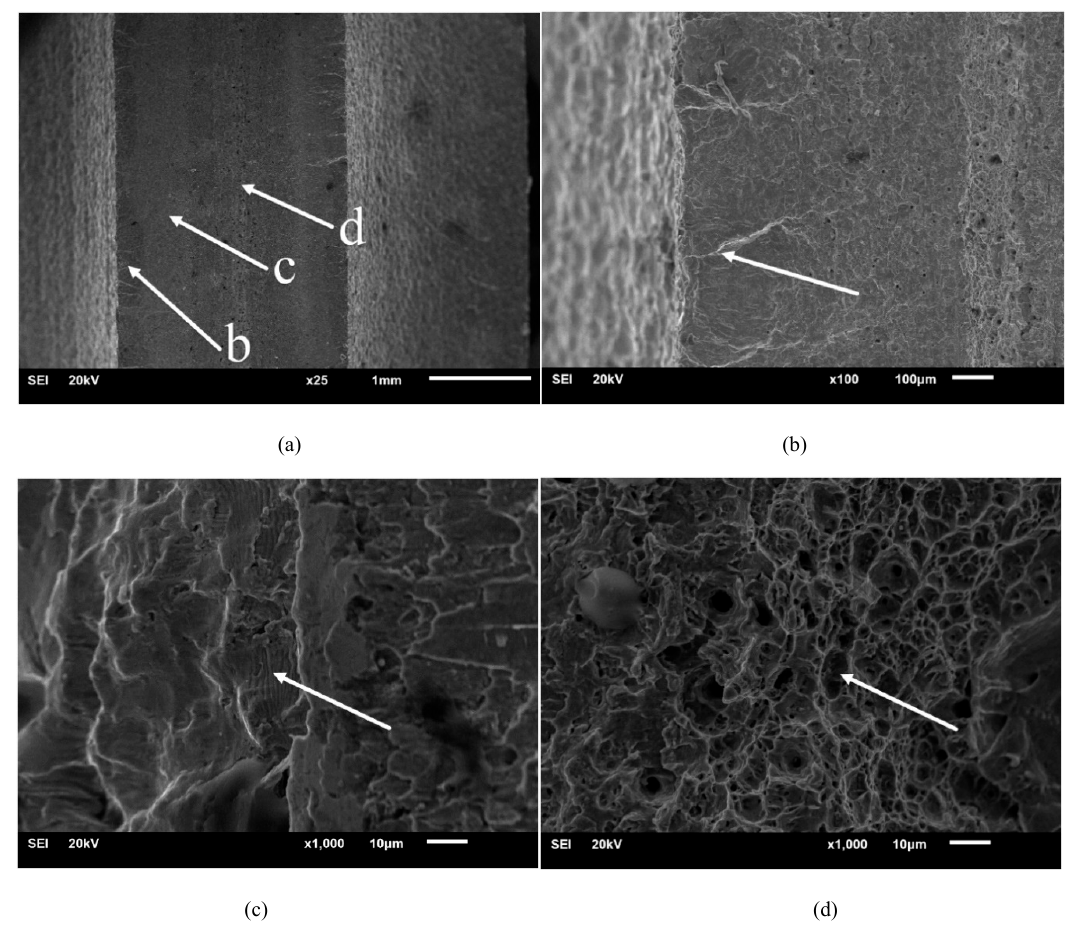
Figure 9 . Fracture morphology of the D_1 specimen. ( a ) Macroscopic fracture, ( b ) crack source zone, ( c ) crack propagation zone and ( d ) instantaneous fracture zone.